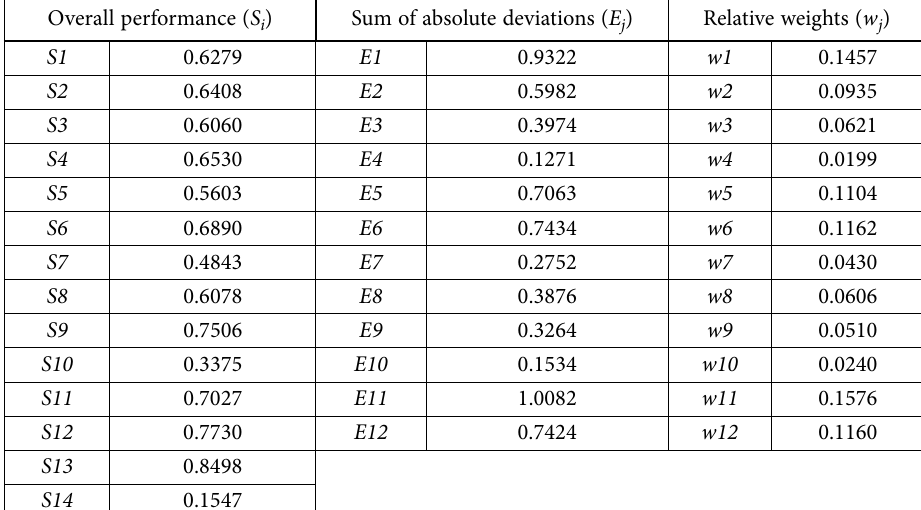
Table 3. Results of the MEREC